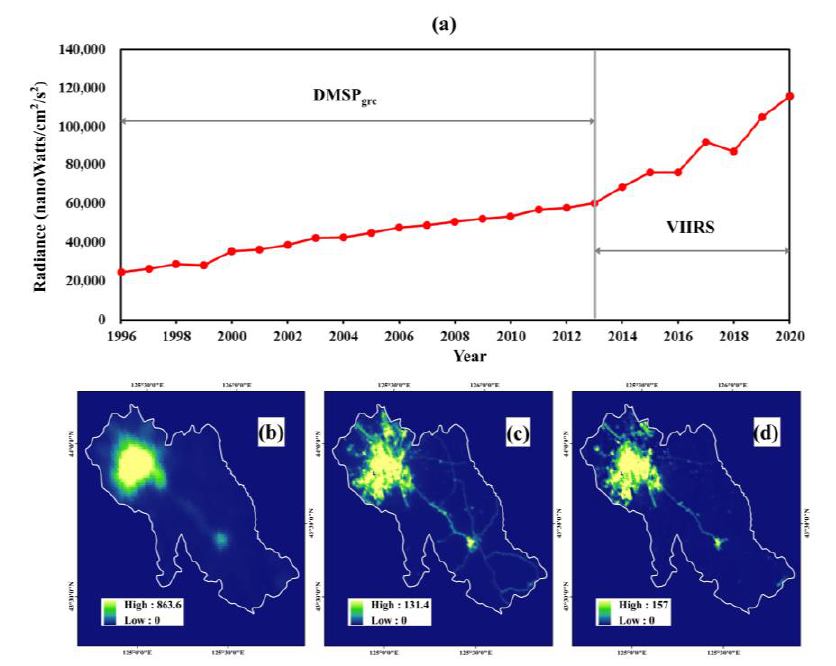
Figure 5. ( a ) The cross-sensor calibration results, with Changchun city, capital of Jilin Province, as an example: the total DN of calibrated time series of NTL data from 1996 – 2020; ( b ) the original DMSP grc image in 2009; ( c ) the VIIRS image in 2017; and ( d ) the calibrated image in 2009.